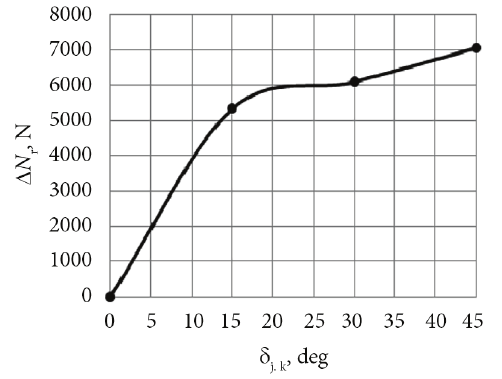
Figure 5. Decrease of